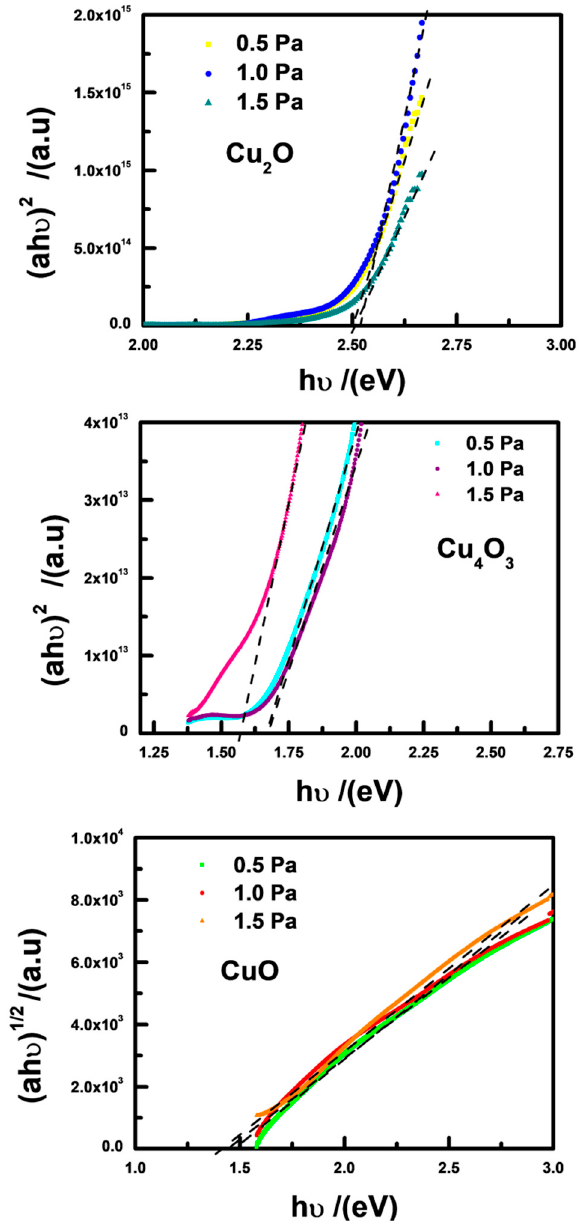
Figure 5. ( α h ν ) n as a function of photon energy ( h ν ) for pure-phase Cu 2 O, Cu 4 O 3 , and CuO thin films.